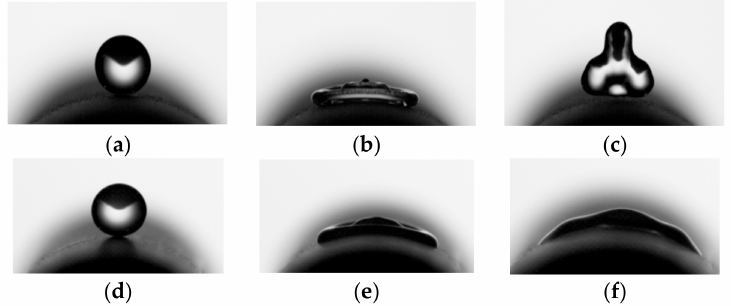
Figure 1. The contact process of droplets on the membrane surface. ( a ) Hydrophobic membrane time: 0 ms contact; ( b ) hydrophobic membrane time: 8 ms spread; ( c ) hydrophobic membrane time: 10.8 ms rebound; ( d ) hydrophilic membrane time: 0 ms contact; ( e ) hydrophilic membrane time: 13.05 ms spread; ( f ) hydrophilic membrane time: 16.85 ms